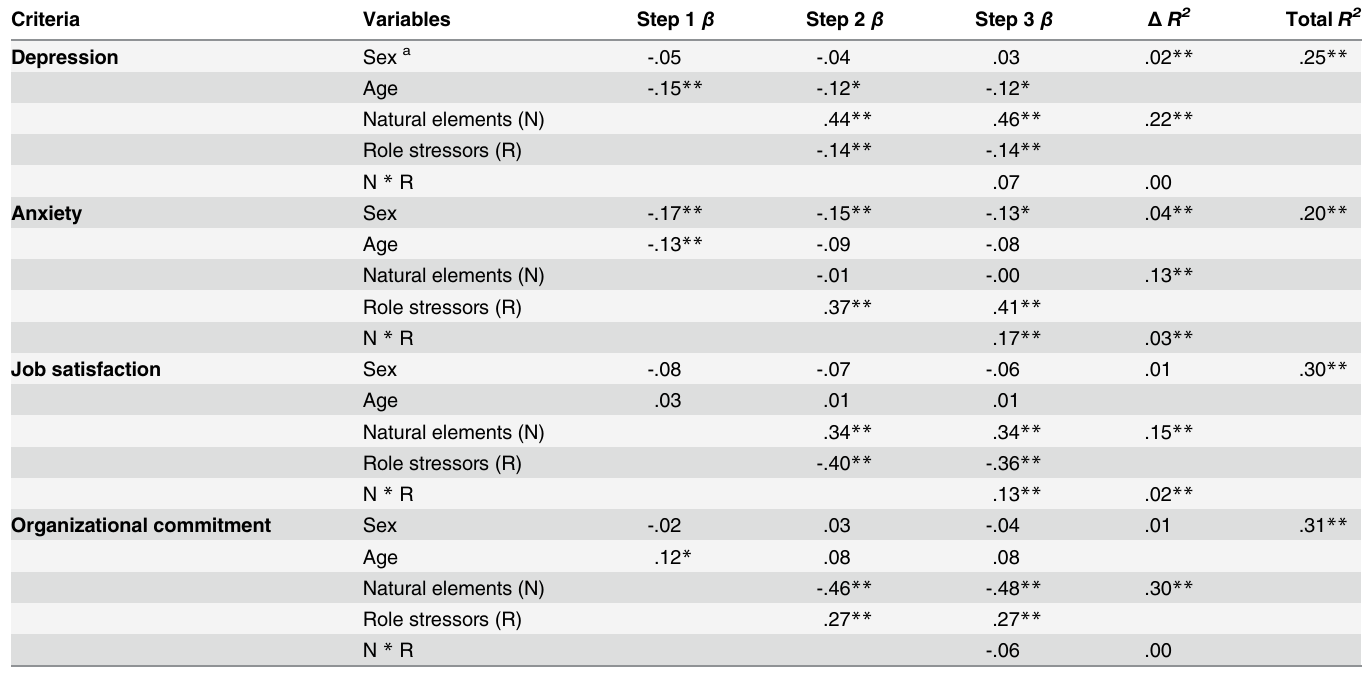
Table 4. The moderating effects of natural elements on outcome variables.